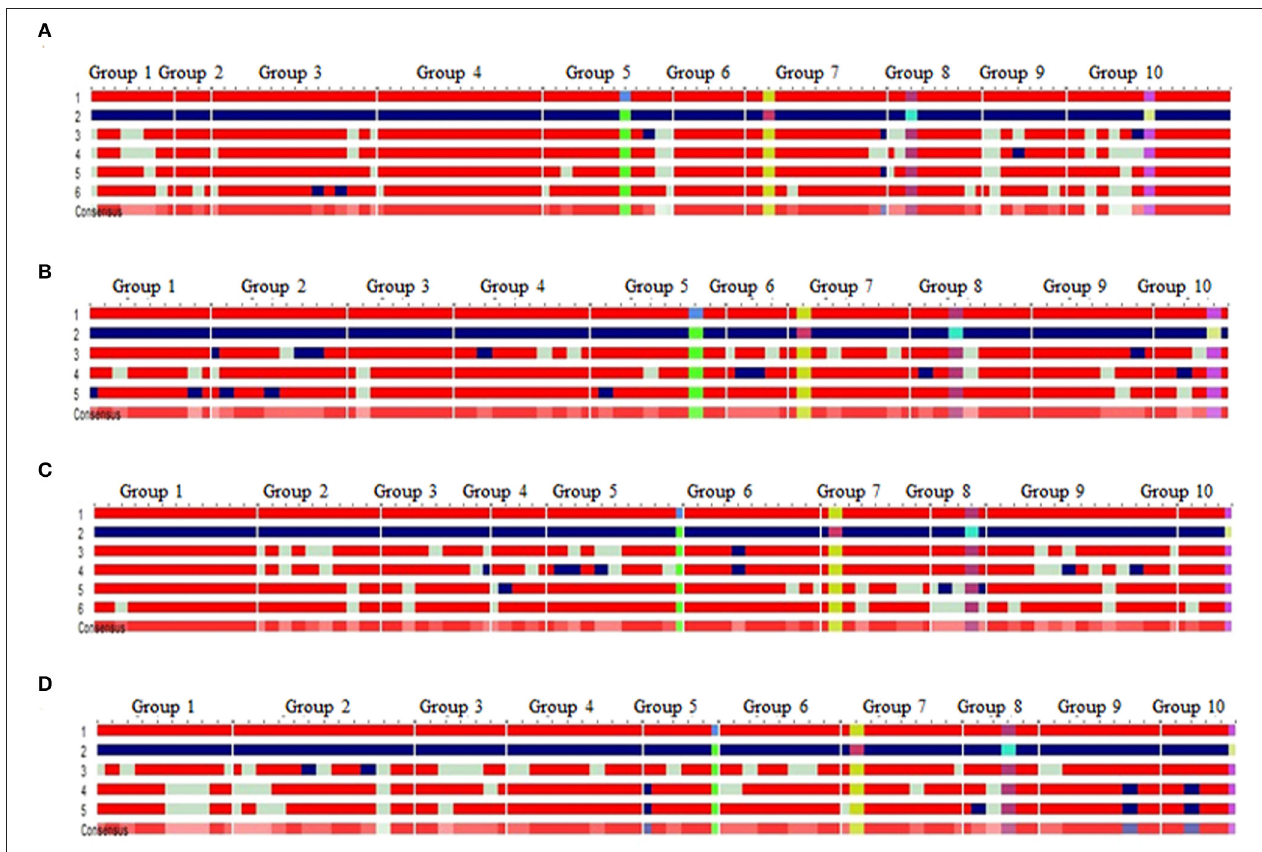
FIGURE 1 | Background recovery of selected progenies in BC 2 F 2 of the RP × DP [ (A) HKI161-VA + VE, (B) HKI163-VA + VE, (C) HKI193-1-VA + VE, and (D) HKI193-2-VA + VE]; 1, recurrent parent (red); 2, donor parent (blue); light green color represent the locus in heterozygous condition; light red color in “consensus sequence” represents the locus having donor allele or heterozygosity, 3–5/6: introgressed progenies; favorable allele of vte4 (green box), favorable allele of phi057 (yellow box), favorable allele of lcyE (purple box), favorable allele of crtRB1 (pink box); group 1–10 represents the chromosome